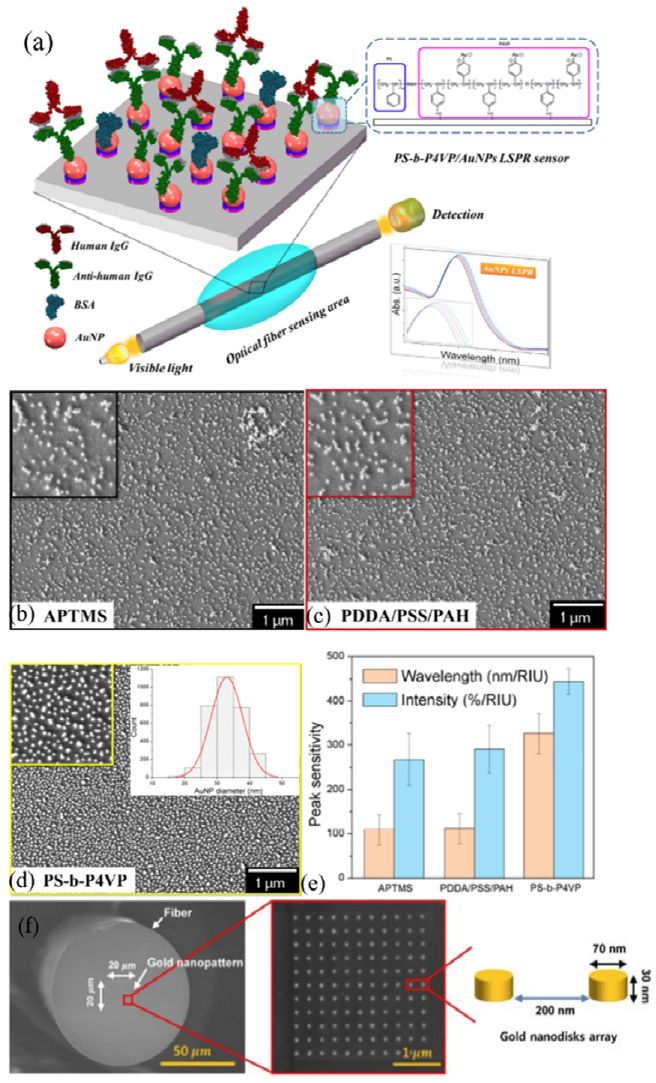
Figure 5. ( a ) Schematic diagram of the PS-b-P4VP-modified LSPR sensor. SEM images of AuNPs templated by ( b ) APTMS, ( c ) LBL-ESA, and ( d ) a PS-b-P4VP brush layer. The diameter of AuNPs is normally distributed. ( e ) RI sensitivities of wavelength and intensity for the three deposition methods. ( f ) SEM image of the Au nanodisk array structure fabricated by the focused ion beam technique and its schematic view. Reprinted with permission from [82,83].